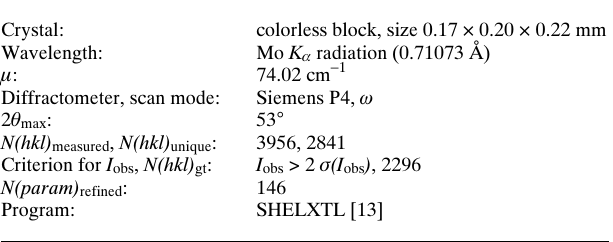
Table 1. Data collection and handling.